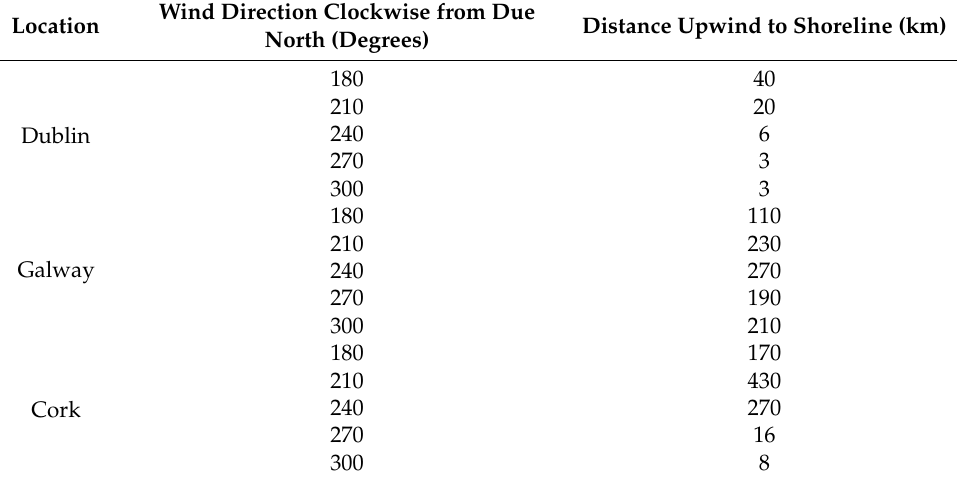
Table 1. Table of distance upwind to the shoreline depending on the location and the direction of the wind clockwise from due north. Wind Direction Clockwise from Due Location North